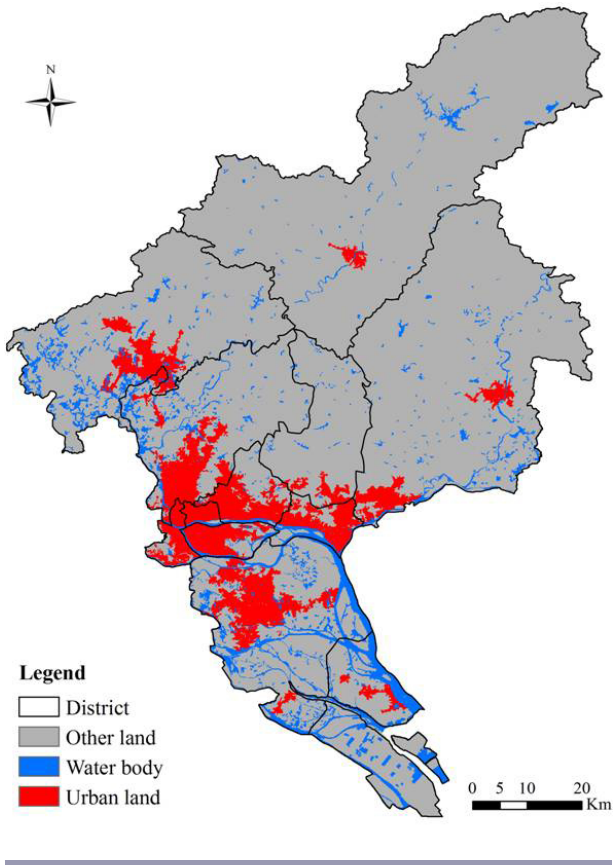
Fig. 1 . The administrative districts and counties of Guangzhou metropolitan